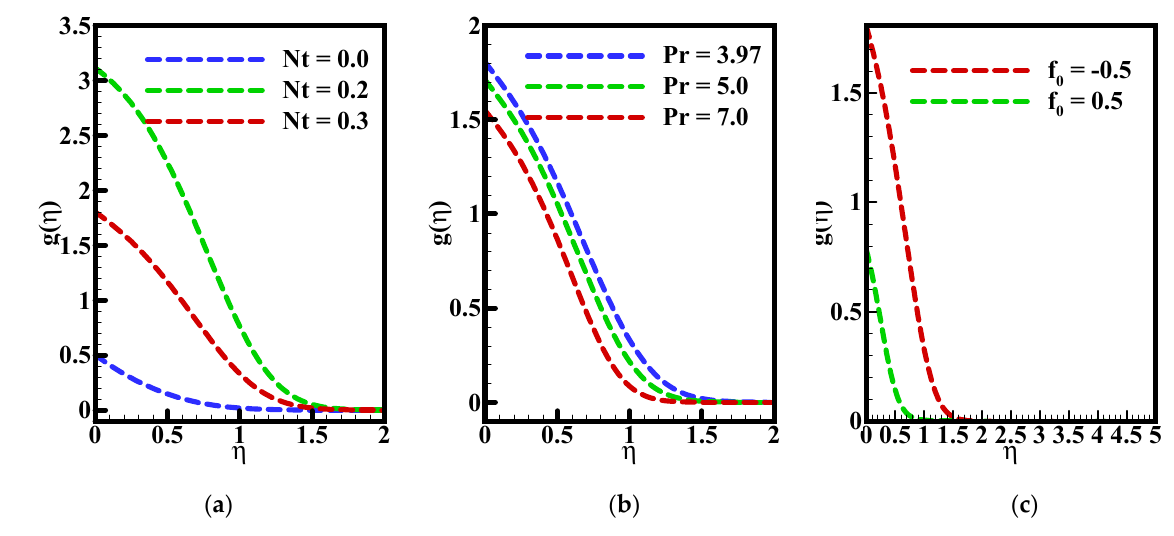
Figure 2. Impact of the parameters ( a ) 𝑓 (cid:2868) , ( b ) 𝑏, and ( c ) Magnetic parameter ( 𝐻𝑎 ) on the dimen- sionless velocity profile and numerous choices of emerging parameters.